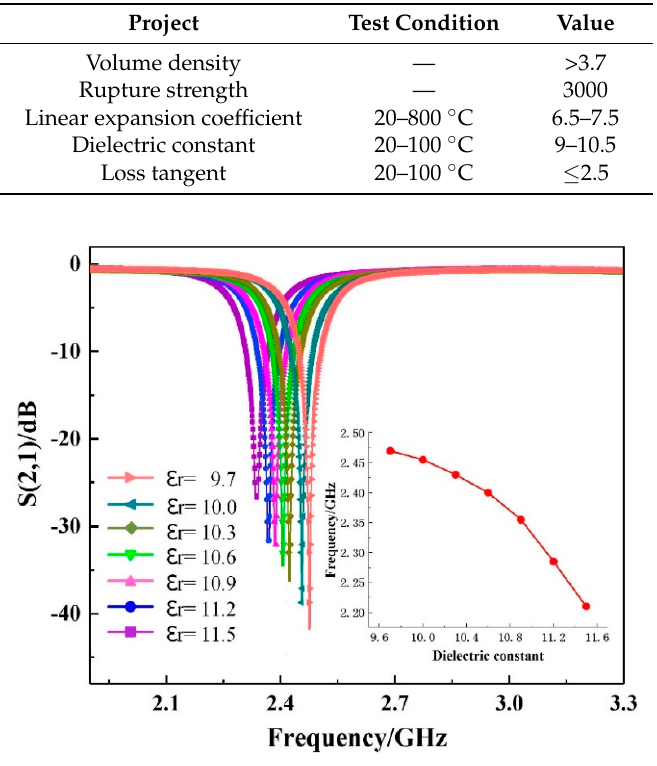
Figure 5. Frequency versus S (2, 1) for different dielectric constants of the alumina ceramic substrate. The insert chart is the frequency versus dielectric constant of the alumina ceramic substrate.